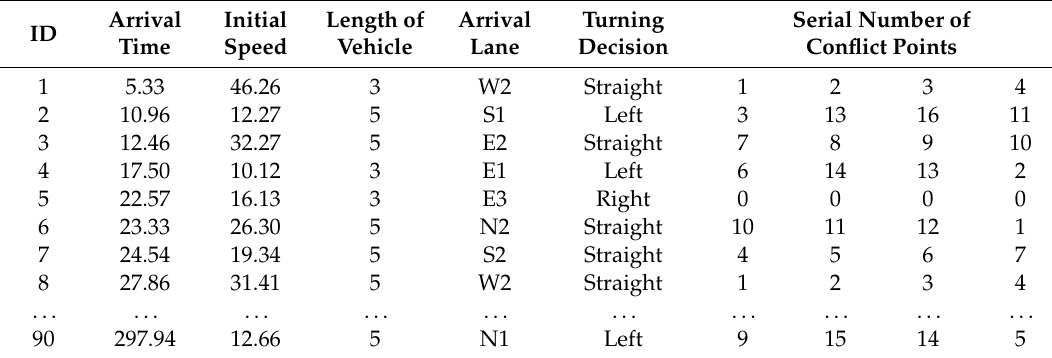
Table 5. An example of a sign-in sheet of vehicles in the 90A test